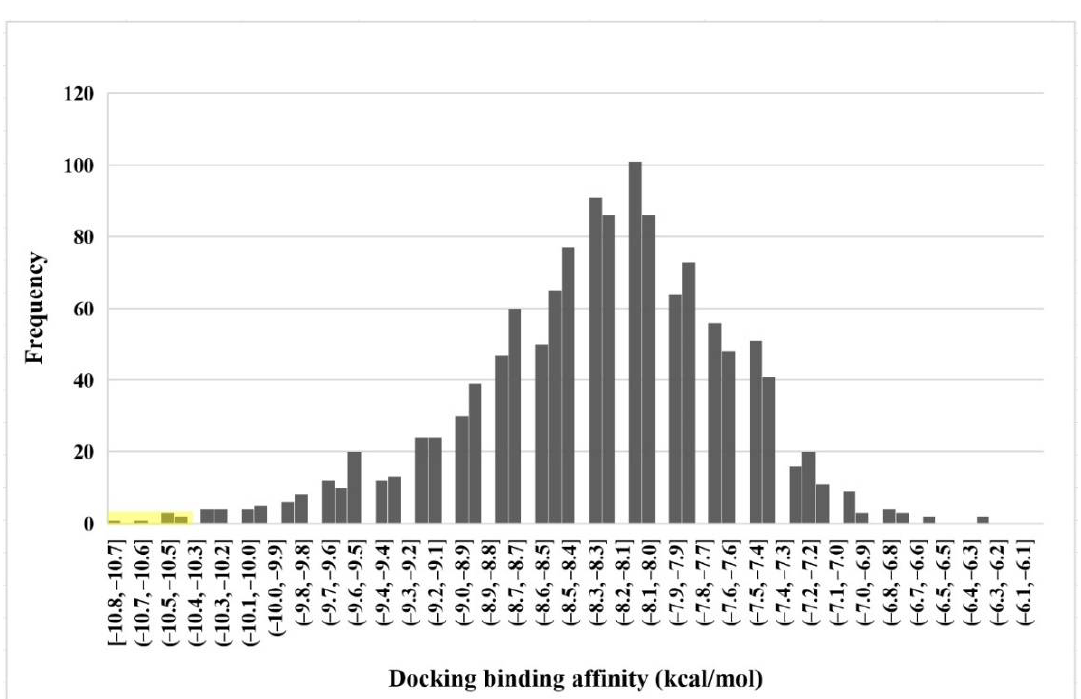
Figure 1. Histogram plot of dock binding affinity of all flavonoids. The dock scores of the selected flavonoids in the left part are highlighted in yellow.